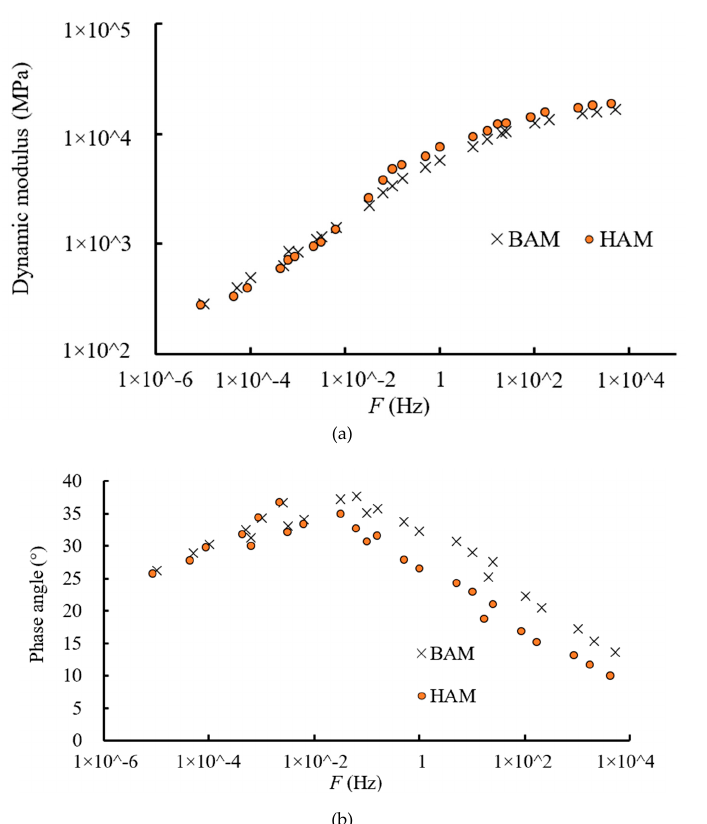
Figure 13. Comparison of dynamic modulus and phase angle master curves: ( a ) dynamic modulus, ( b ) phase angle.